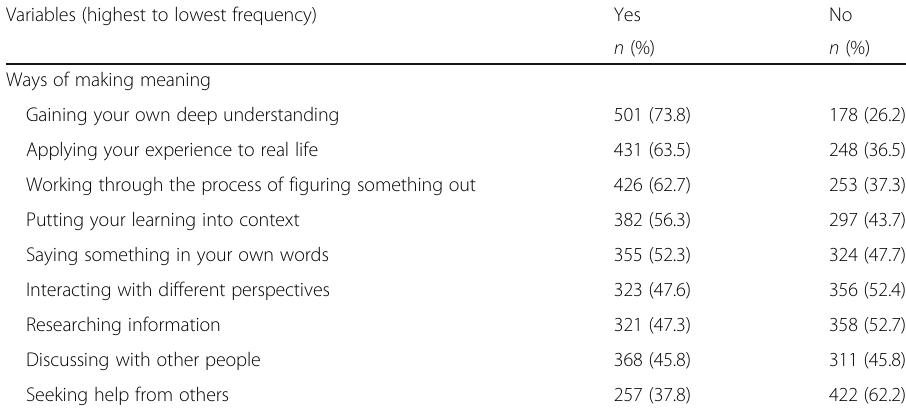
Table 2 Q10: How do you make meaning ( “ make sense ” ) of your university learning? Variables (highest to lowest